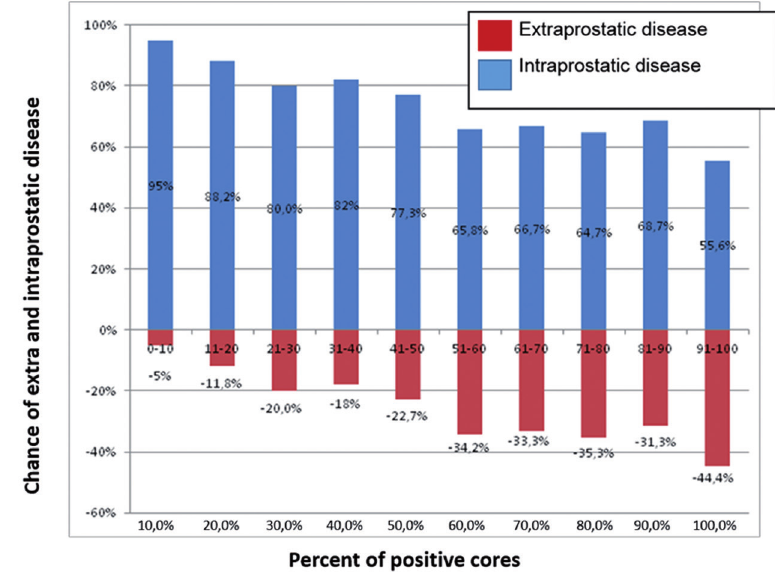
Figure 2 - Chance of extraprostatic disease in patients without grade 4 or 5 component in the biopsy Gleason